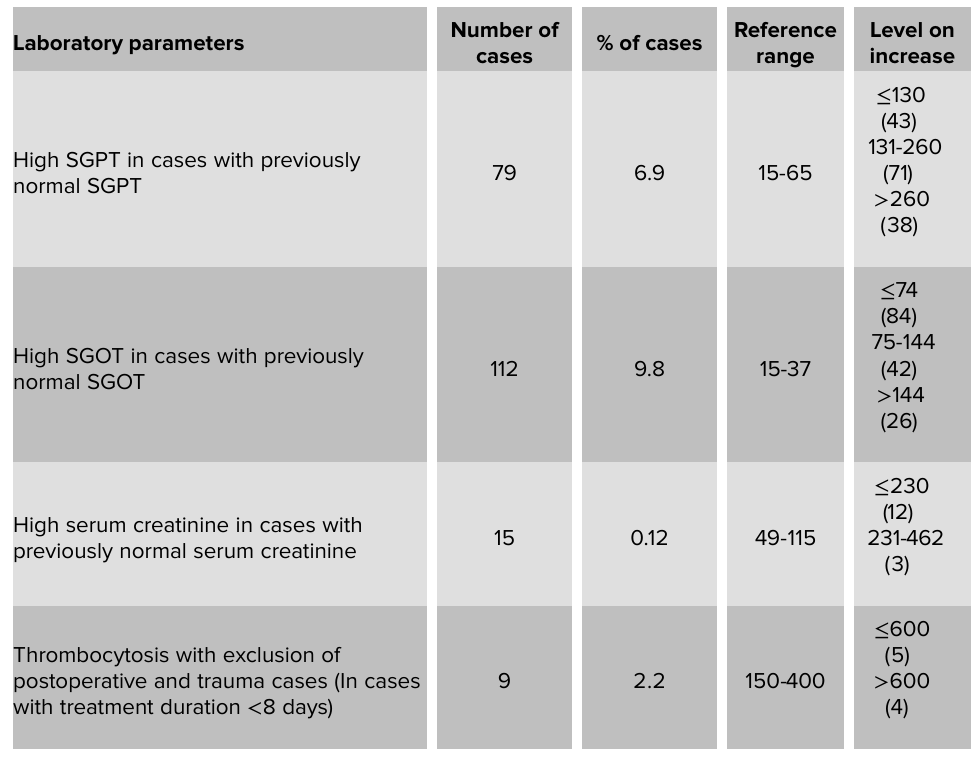
Table 5: Ceftriaxone safety profile on remarks to liver function, renal function and complete blood count.